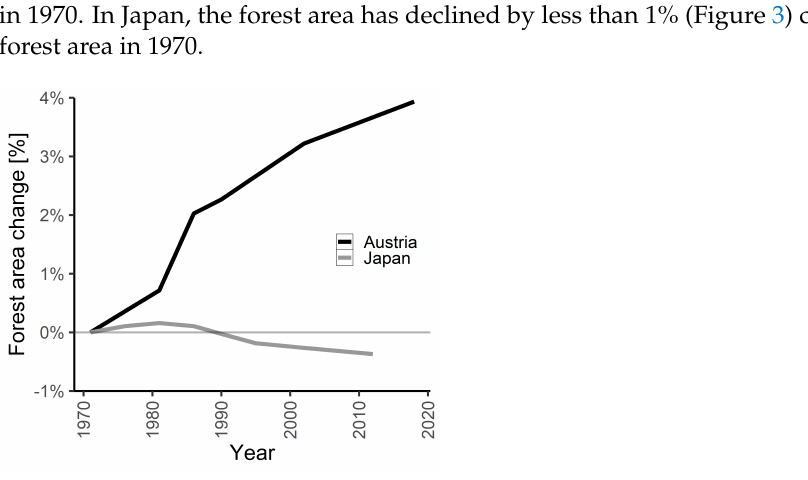
Figure 3. Change in forest area since 1970 according to data from the Austrian National Forest Inventory (2018), BMLFUW (2015), and Forest Agency